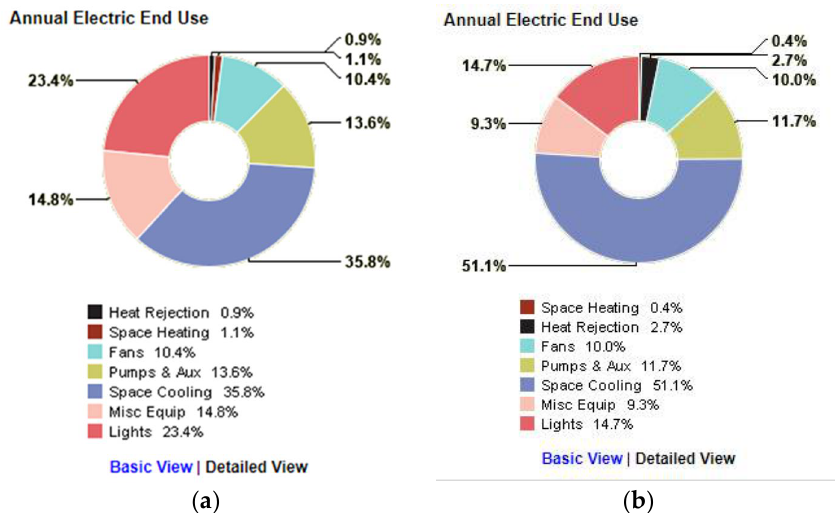
Figure 8. Annual electric end-use charts obtained by Green Building Studio. ( a ) Sydney; ( b ) Dubai. Some values of EUI can be similar between them, as is the case of the EUI for Armação